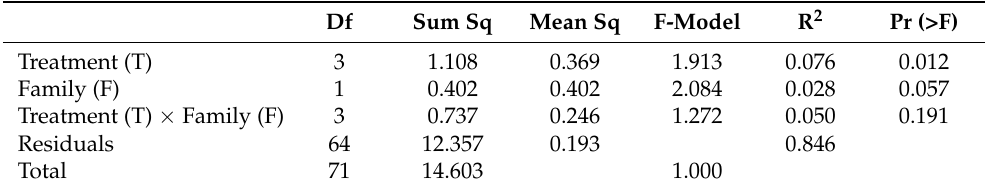
Table 3. PERMANOVA showing variability among fish gut microbiota across all samples originating from the hatchery. Df Sum Sq Mean Sq F-Model R 2 Pr (>F) Treatment (T) 1.108